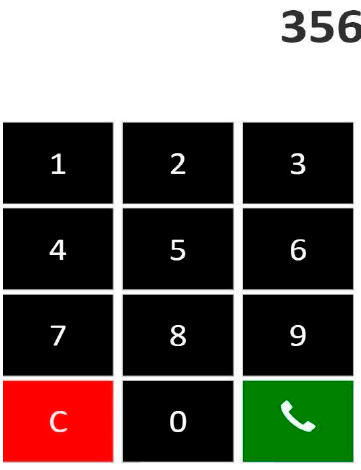
Figure 3. Phone app.